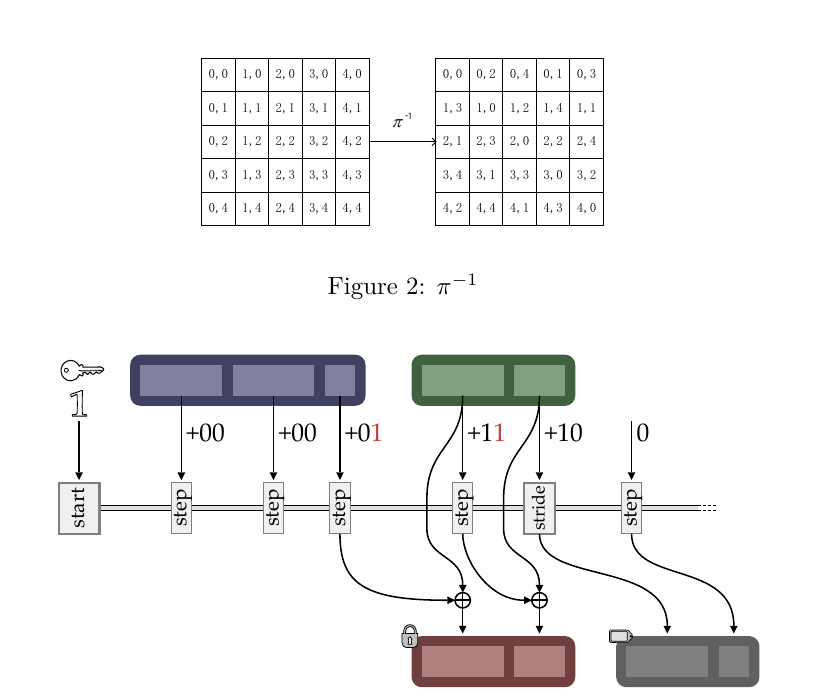
Figure 3: Wrapping a Header and a Body with MonkeyWrap [BDP + 16a] Figure 2: Wrapping a header and a body with M(cid:1116)(cid:1115)(cid:1112)(cid:1106)(cid:1126)W(cid:1119)(cid:1102)(cid:1117)